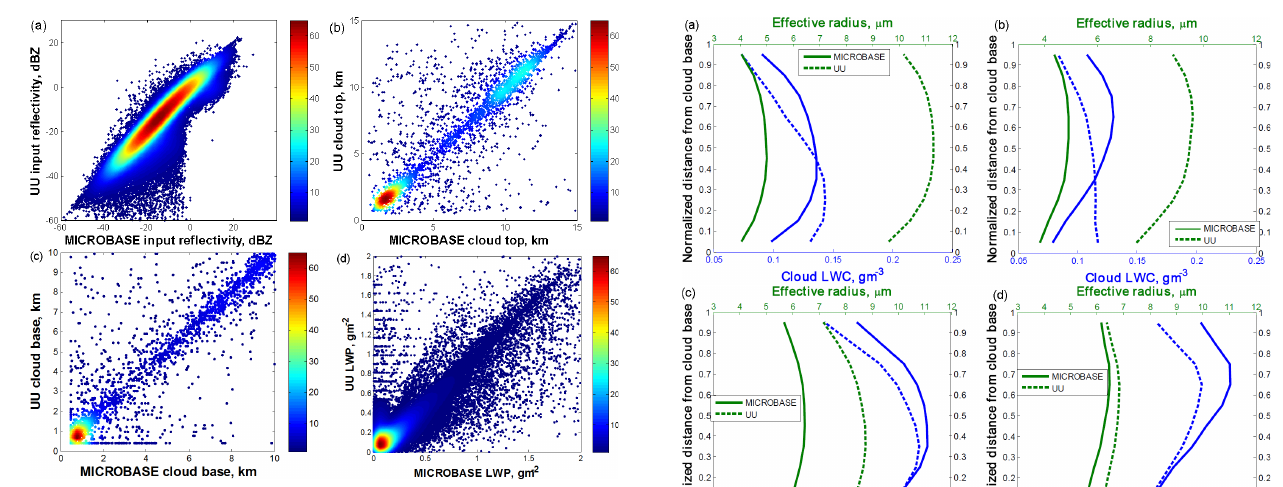
Fig. 10. Scatter plots of MICROBASE and UU input radar reflec- tivity factors (a) , cloud base heights (b) , cloud top heights (c) , and cloud LWPs (d) from 1998 to 2006. Color coding is used to indicate point density. Fig. 11. MICROBASE and UU cloud LWC and r e as a function of